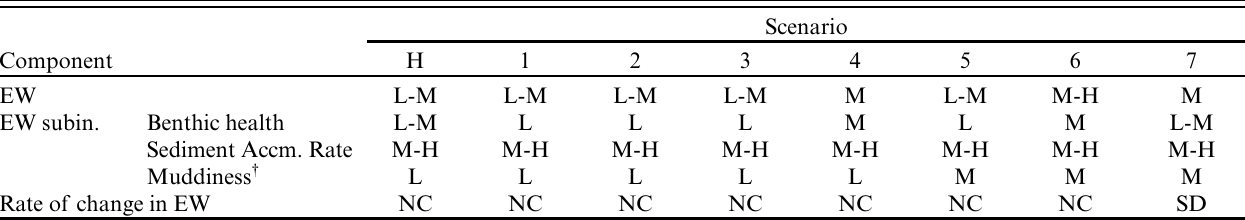
Table 6 . Natural capacity components following historic development (H) and future urban development Scenarios 1 to 7, Lucas Creek catchment. Environmental well-being (EW) and subindicators (subin.) fall into one of the following categories: low (L), low-medium (L-M), medium (M), or medium-high (M-H). The rate of change in EW is either no change (NC) or slow decline (SD).